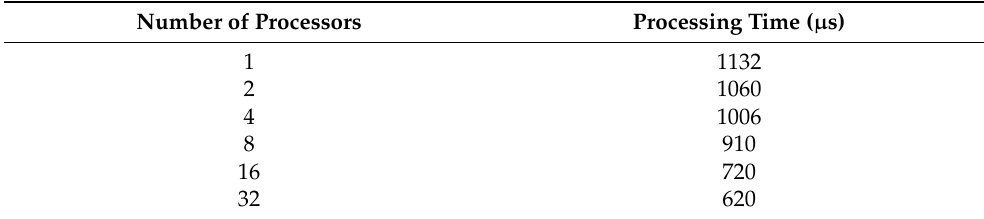
Table 1. Dependence of the execution time of distributed calculations of singular data decomposition depending on the number of computational processes.